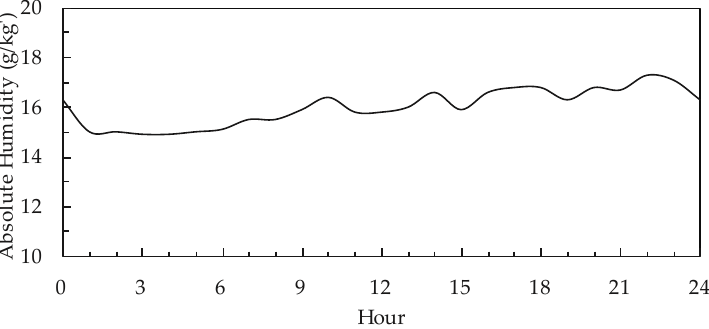
Figure 13. Variations in the daily outdoor air temperature and relative humidity in Tokyo, Japan, according to the AMeDAS standard weather data (15 June).